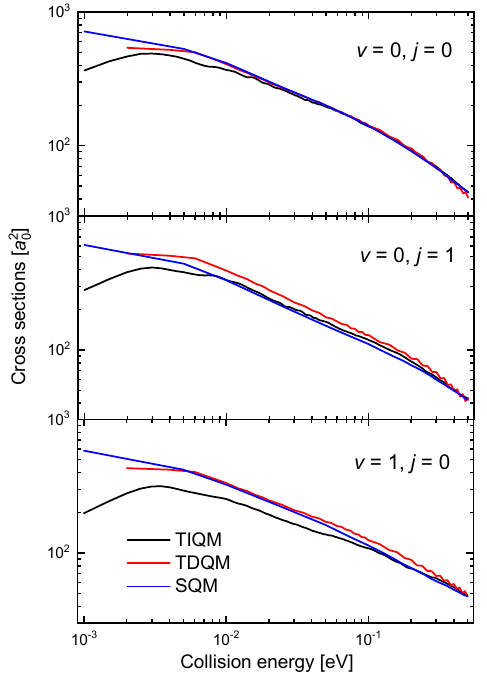
Figure 10. ICSs (in a 2 ) as a function of the collision energy (in eV) for the Ne + HeH + ( v = 0, j = 0 ) → 0 He + NeH + reaction with a TDQM (red lines), TIQM (black line), SQM (blue lines) and QCT (open circles) calculations from Refs.